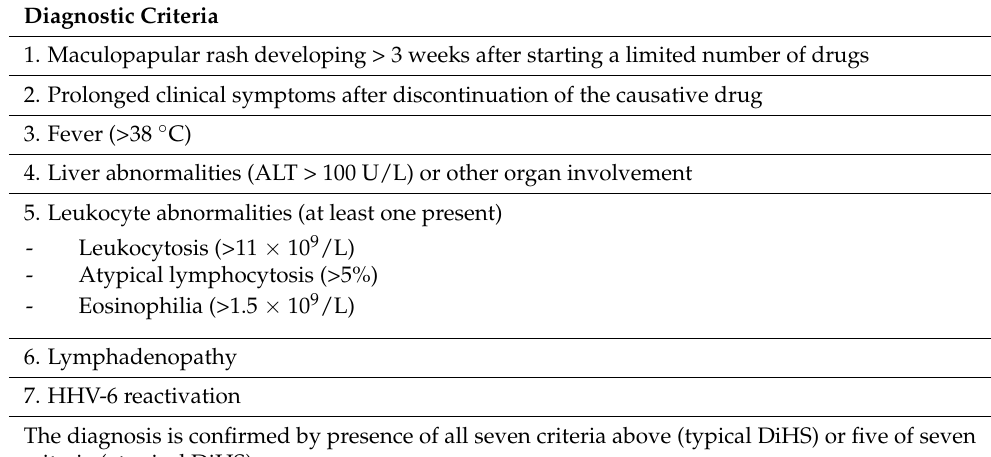
Table 3. Diagnostic criteria for DiHS established by Japanese consensus group [21].